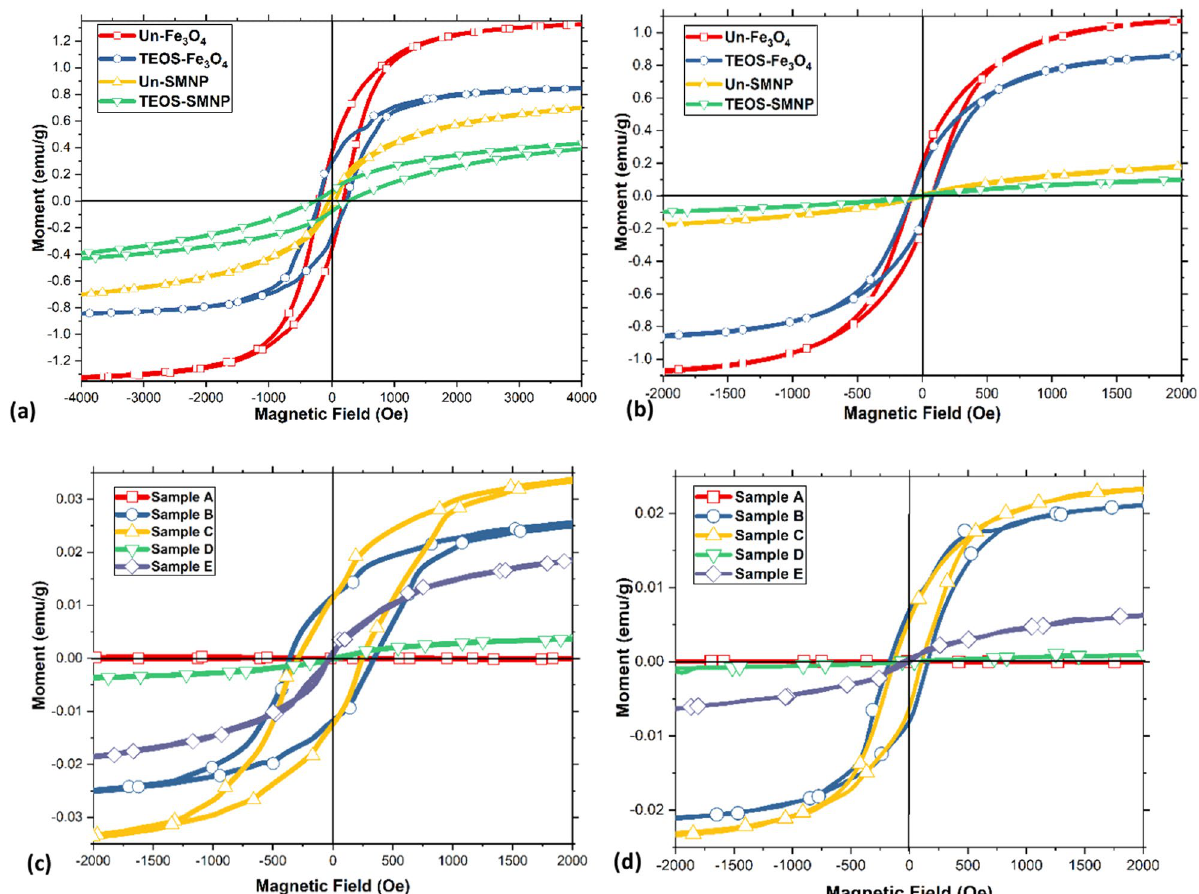
Figure 4. Magnetization hysteresis (M-H) loops for ( a ) MNP samples at 100 K, ( b ) MNP samples at 400 K, ( c ) SHMNP composite samples at 100 K and ( d ) SHMNP composite samples at 400